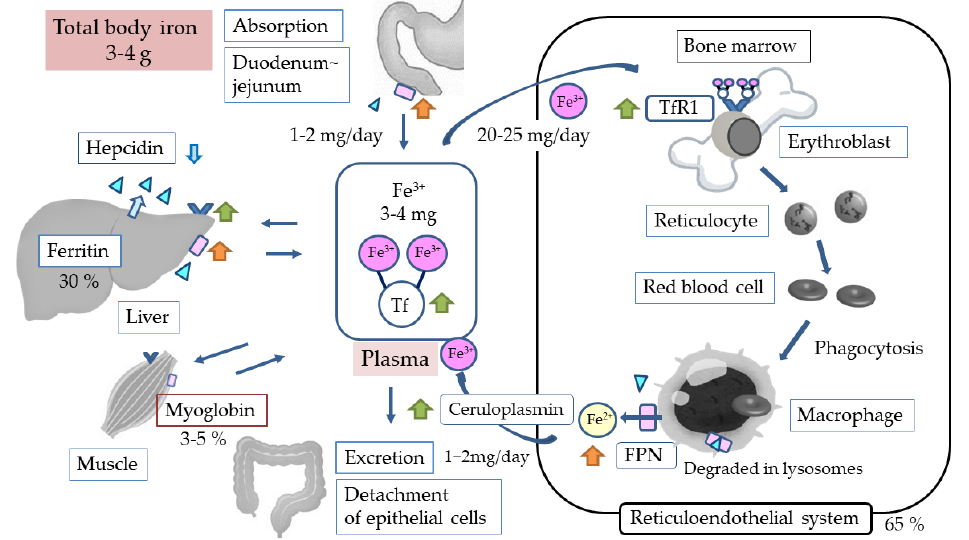
Figure 2. General iron metabolism. Tf, transferrin; TfR1, transferrin receptor1 ( ); FPN, ferro-